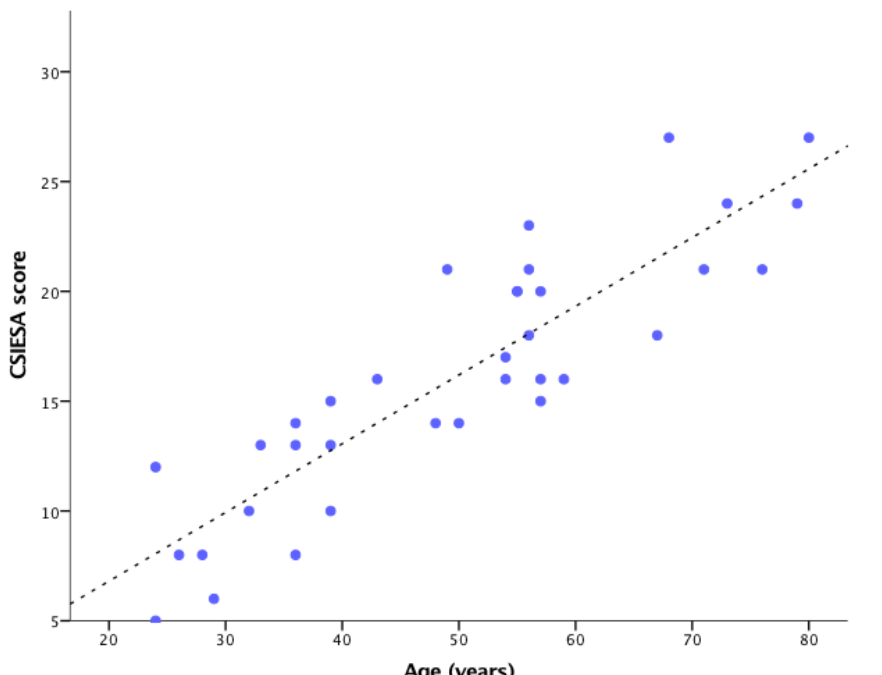
Figure 9. The CSIESA confocal score correlated with the age of every subject.